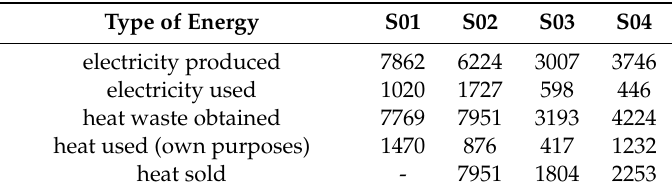
Table 2. Life cycle inventory for energy production and use in four di ff erent biogas plants in MWh per